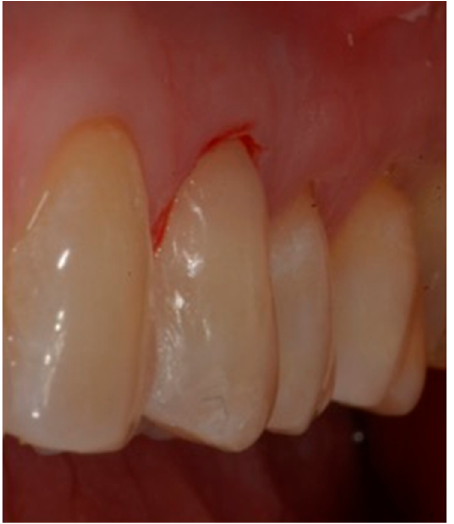
Figure 6. ( a ) A thin layer of flowable composite was applied; ( b ) a paste composite was applied with a convex profile; ( c ) every layer of the composite was polymerized for 20 s .